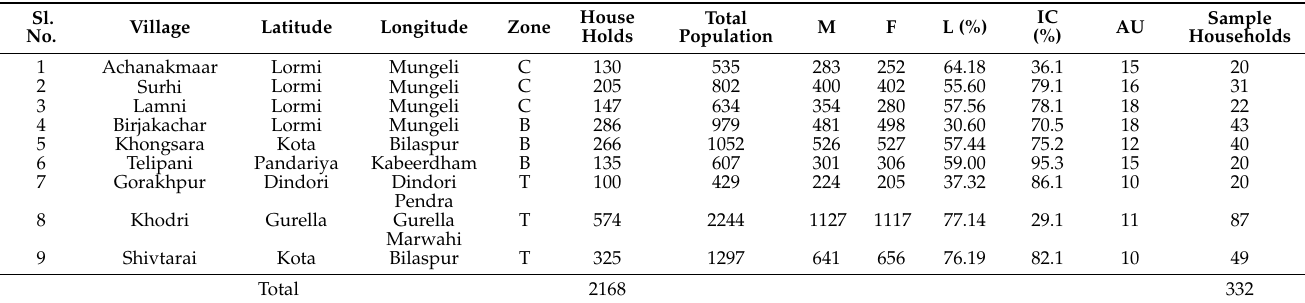
Table 1. Socio-demographic characters of sample villages in Achanakmaar Amarkantak Biosphere Reserve. Sl. Village Latitude No.